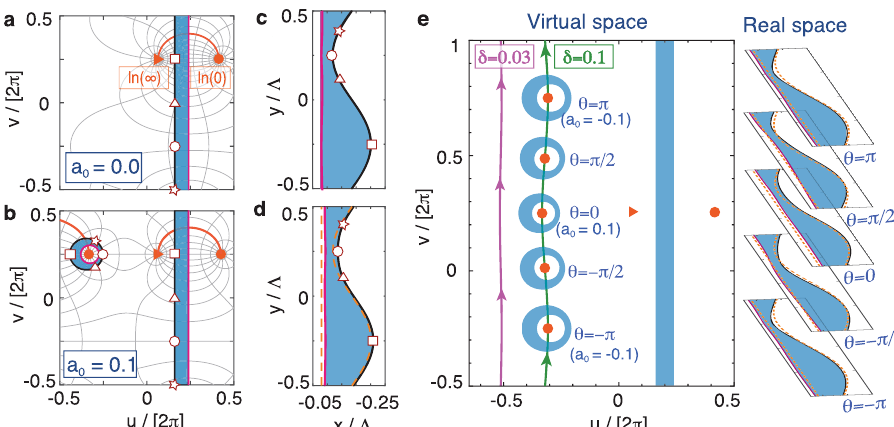
Fig. 1 The multiplicity of a conformal mapping. Metasurface geometries in a , b the virtual space (u-v frame) and in c , d the real space ( x – y frame). The relation between these two spaces is governed by the transformation in Eq. (1), and its contour plot containing the isolines of real and imaginary parts of z is shown by the light-gray solid lines in a , b . The fi lled orange circles and triangle markers in a , b , and e denote the ln ð 0 Þ and ln ð1Þ singularities of the mapping, respectively. The solid orange lines in a and b denote the branch cut of the mapping, terminating at the ln ð 0 Þ and ln ð1Þ singularities. All the magenta and black solid lines in a , b correspond to the boundary of the metasurface with the same colors shown in c , d , showing the multiplicity of the mapping. To further demonstrate such multiplicity, four points along the black line of the slab in a , b with coordinates ( u , v ) = (1, − π ), (1, − π /2), (1, 0), and (1, π /2) are highlighted by the open stars, circles, triangles, and squares, and their equivalent points are shown by the same markers in c , d and in the eccentric cylinder of the virtual space in b . The values of a 0 are 0 in a and c , and 0.1 in b and d . Other geometric parameters are Λ = 30 π nm, w 0 = 1.5, u = 1, and d = 0.5. e The left panel illustrates the geometries of the plasmonic metasurfaces in the virtual space for a complex a 0 lines show the trajectories of the ln(0) singularities as θ varies from − π to π , for two values of δ = 0.1 (green) and δ = 0.03 (purple). Along the solid green line, we depict the eccentric cylinders with different values of θ , and their corresponding metasurfaces in the real space are shown in the right panel. The orange dashed lines highlight the metasurfaces when δ = 0.